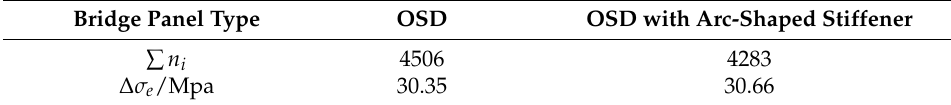
Figure 9. Comparative analysis of maximum stress amplitude of concern. As seen in Figure 9, the maximum stress amplitude of concern point 1 is less than the fatigue limit of 28.34 MPa. Concern point 1 assumes an infinite life without considering the fatigue life. The maximum stress of concern point 2 is greater than the fatigue limit, and the fatigue life was evaluated with the fracture mechanics method. The equivalent stress amplitude of concern point 2 is shown in Table 6. Table 6. Equivalent stress